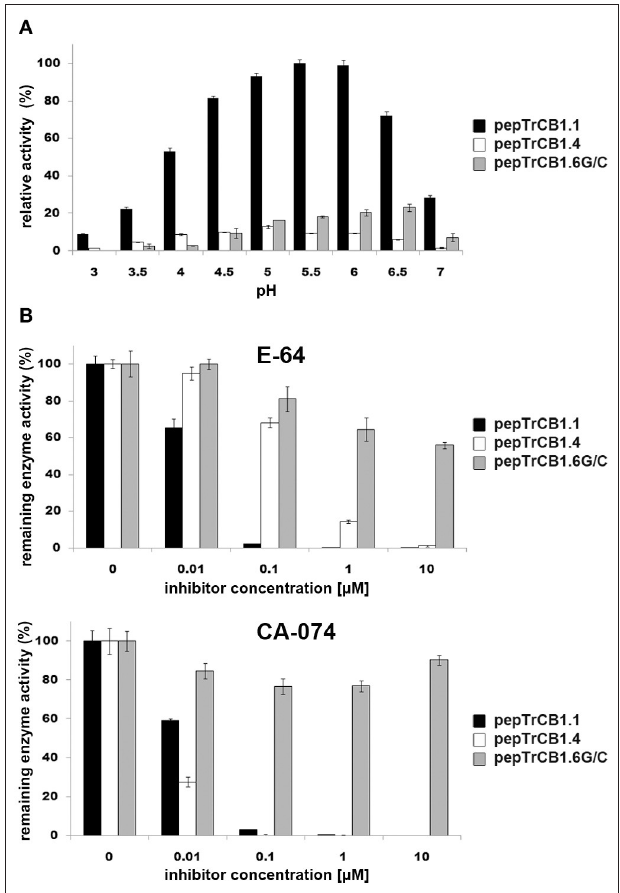
FIGURE 6 | pH optima of the pepTrCB1 forms and effect of inhibitors on enzyme endopeptidase activity. (A) The effect of pH on peptidolytic activity of pepTrCB1.1, pepTrCB1.4, pepTrCB1.6G/C toward the fluorogenic peptidyl substrate Z-Phe-Arg-AMC was measured in 50/100mM CPB (pH range 3–7) with 2mM DTT. Data are expressed as percentage of relative activity in the sample. (B) Effect of cysteine peptidase inhibitors (E-64, CA-074) on the activity of pepTrCB1.1, pepTrCB1.4, pepTrCB1.6G/C toward Z-Phe-Arg-AMC substrate. Inhibition assays were carried out at pH optimum of the